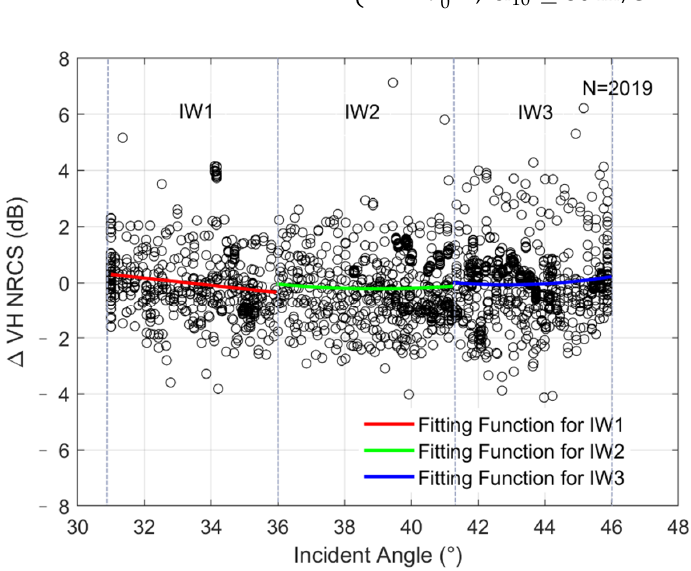
Figure 4. The difference between SAR-observed and Equation (5)-simulated VH NRCS for wind speeds less than 30 m/s under different incident angles.